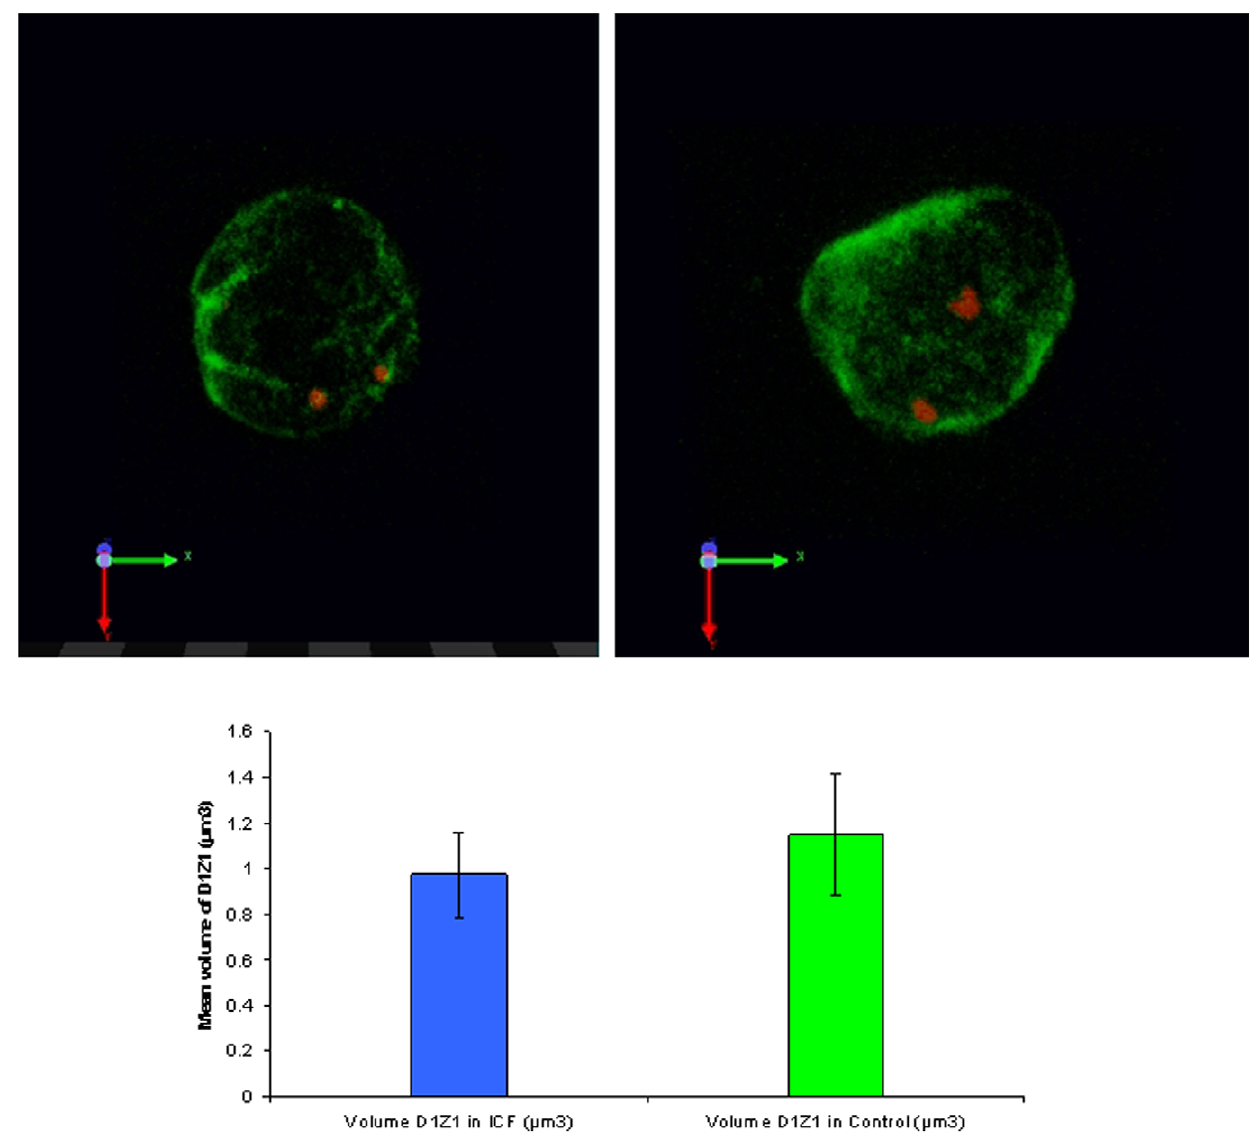
Figure 4. Chromosome 1 juxtacentromeric heterochromatin: volume measurements in ICF cells and controls. The nuclear volumes occupied by the chromosome 1 juxtacentromeric heterochromatin, as defined by hybridisation with the D1Z1 classical satellite DNA probe (red) on 3D-fixed interphase nuclei (immunostained with anti-Lamin B, green), were measured and compared in ICF Patient 1 and Control 1 as described in the Materials and Methods. The heterochromatin was shown to occupy on average a smaller volume in ICF cells. The data sets were compared using a Kolmogorov-Smirnov test, which revealed a statistically significant difference between the ICF and Control volume distributions (D=0.2356, P , 0.001). Examples of variable heterochromatin patterns as observed by 3D-FISH, confocal analysis and volume reconstruction are shown in the top panels.